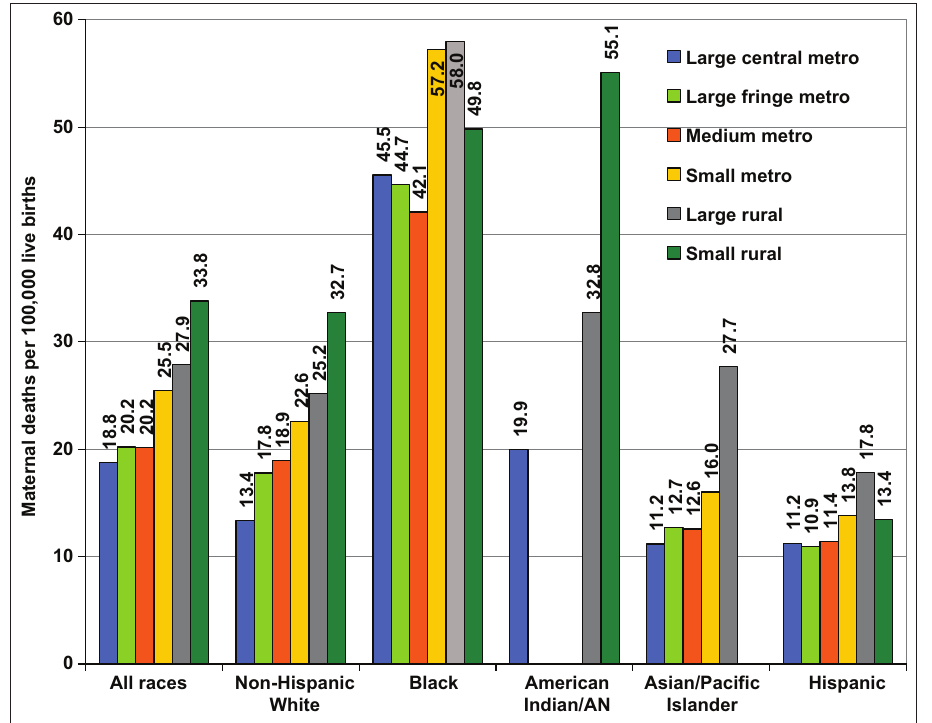
Figure 2 : Maternal Mortality Rates by Levels of Urbanization, United States, 2013-2017. Source: Data derived from the National Vital Statistics System. Metropolitan (urban) counties include: (1) large central metro (inner-city counties of MSAs (metropolitan statistical areas) of ≥1 million population), (2) large fringe metro (suburban counties of MSAs of ≥1 million population), (3) medium metro (counties of MSAs of 250,000-999,999 population), (4) small metro (counties of MSAs with <250,000 population). Nonmetropolitan (rural) counties include: (5) micropolitan (large rural) counties in micropolitan statistical areas (population 10,000 to 49,999), (6) non-core (small rural) nonmetro counties that are not in a micropolitan statistical area. For American Indians and Alaska Natives, the mortality rates are shown for all metro areas combined, large rural areas, and small rural